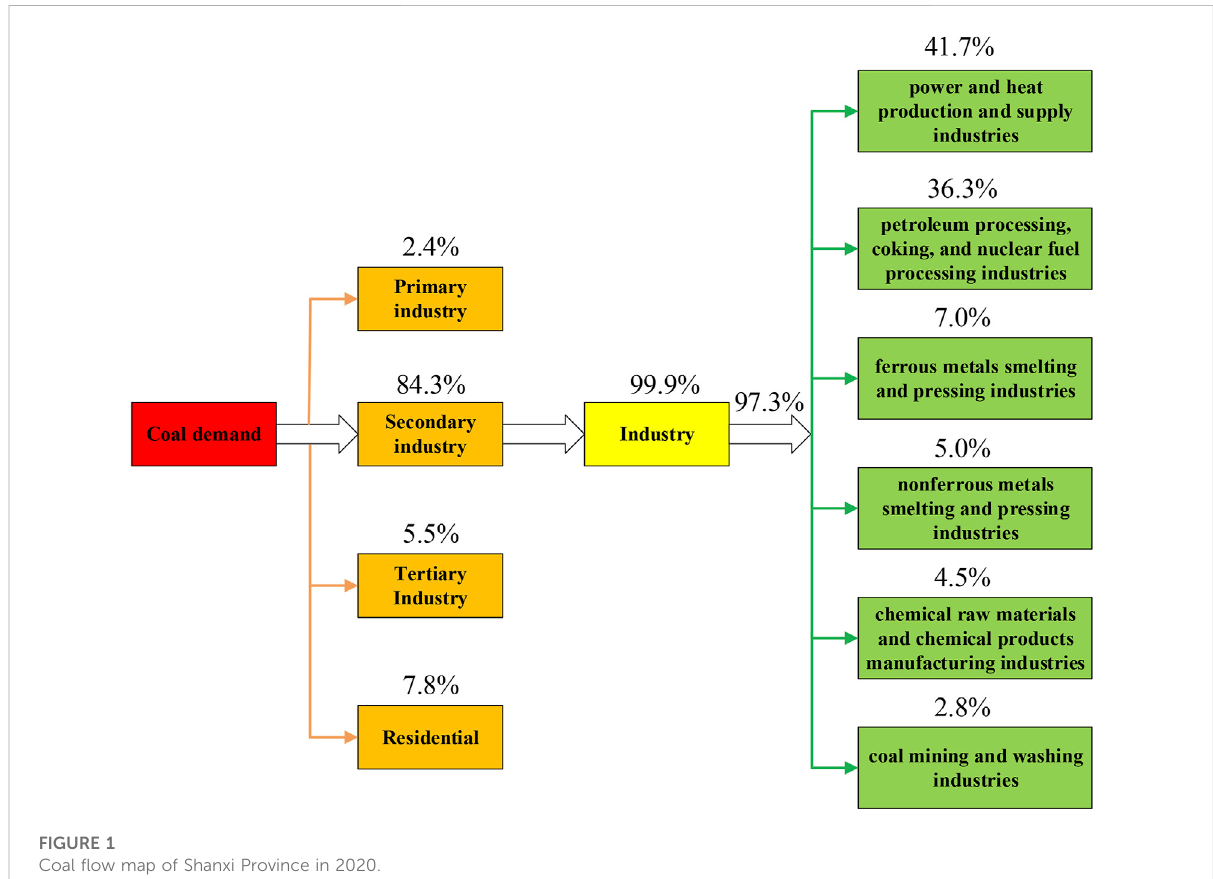
FIGURE 1 Coal fl ow map of Shanxi Province in